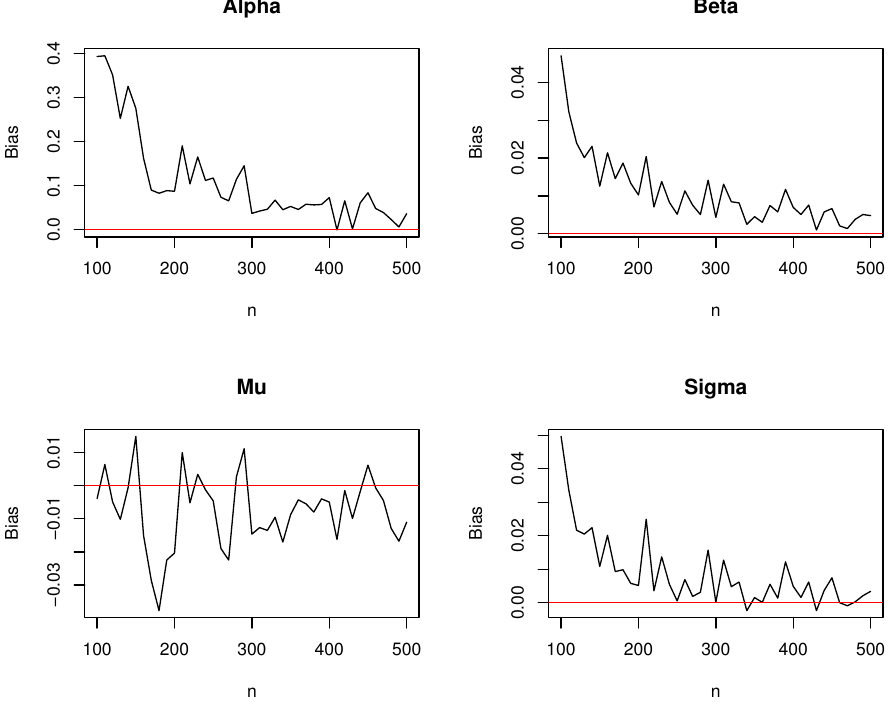
Figure 4. AB of the MLE ˆ Θ of the vector parameter Θ